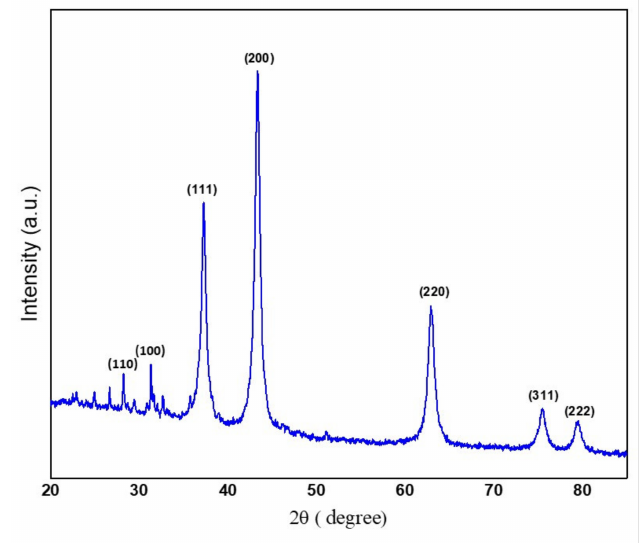
Figure 1. X-ray diffraction patterns revealing the crystal planes of as-prepared NiO NPs.